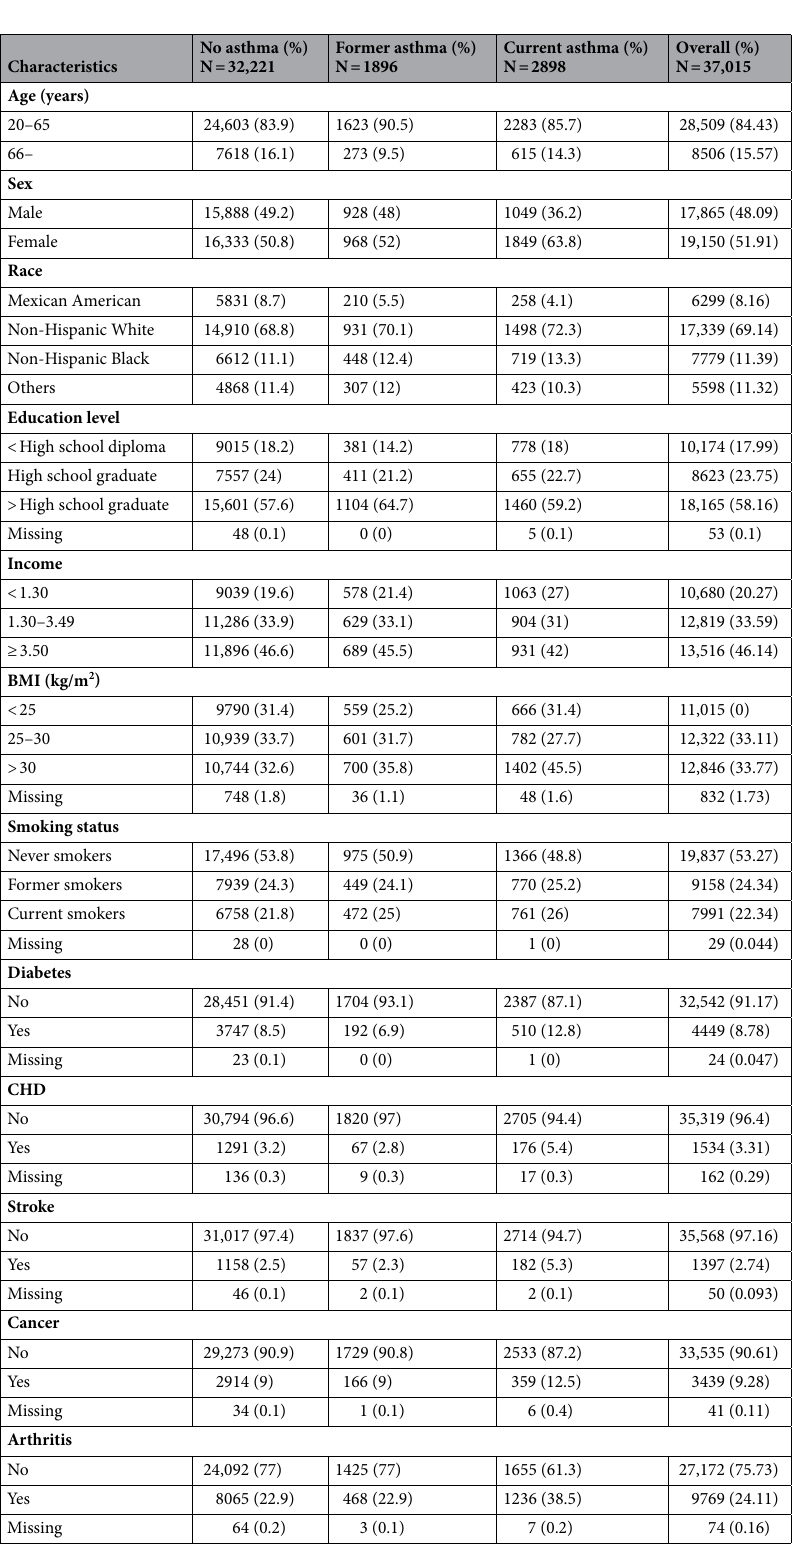
Table 1. Baseline characteristics of the study participants according to asthma status. BMI body mass index, CHD coronary heart